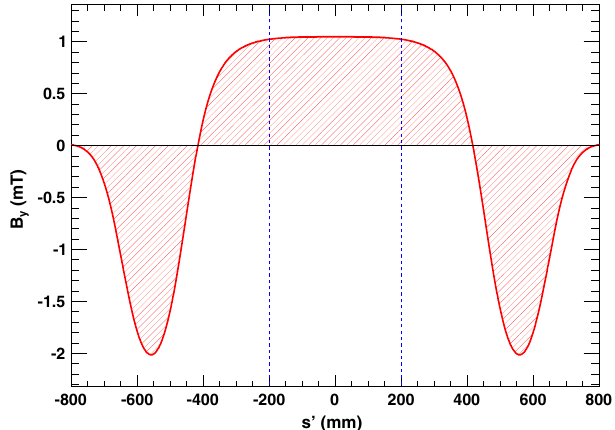
FIG. 8. Difference of the horizontal orbit position Δ x ¼ x along the y x along COSY for reversed vertical holding B y ↓